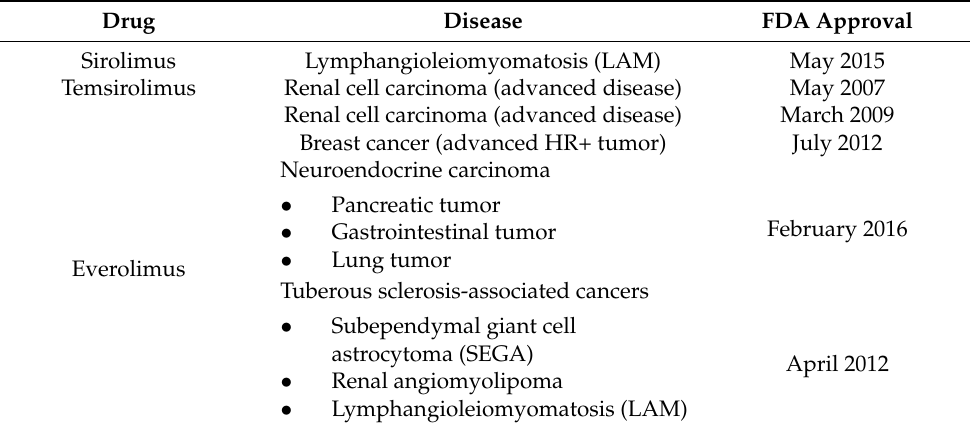
Table 1. FDA approved mTOR inhibitors. The FDA has approved the use of mTOR inhibitors in the management of six cancers as of November 2021 [15–18]. Drug Disease FDA Approval